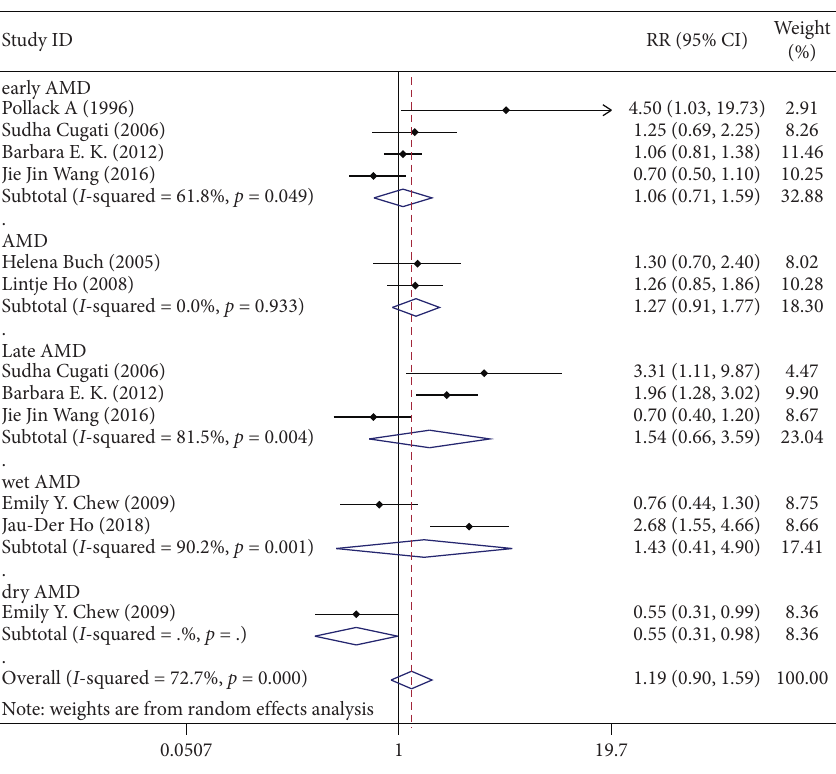
Figure 7: Subgroup analysis on different AMD classification.